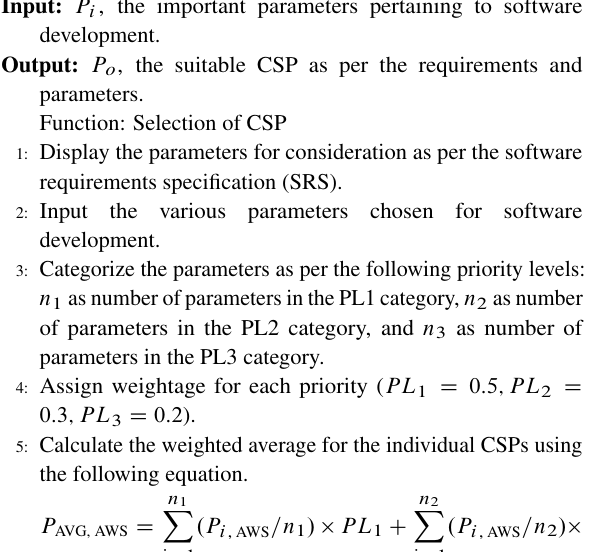
Algorithm 1 PRPLW-based CSP selection algorithm